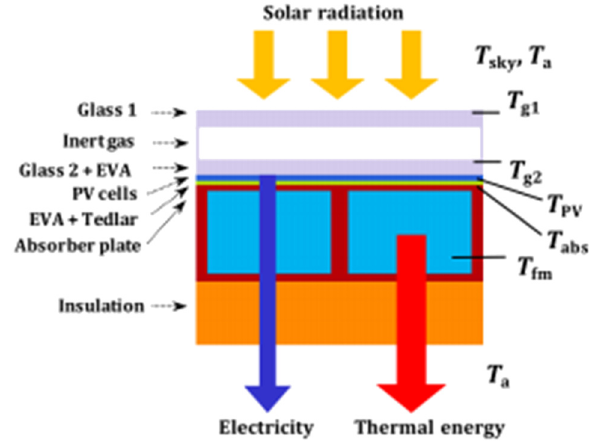
Figure 1: Schematic of the box con fi guration of the photovoltaic thermal collector [ 14 ]